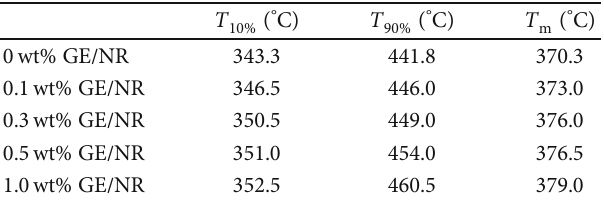
Table 1: Degradation temperatures of GE/NR composites.